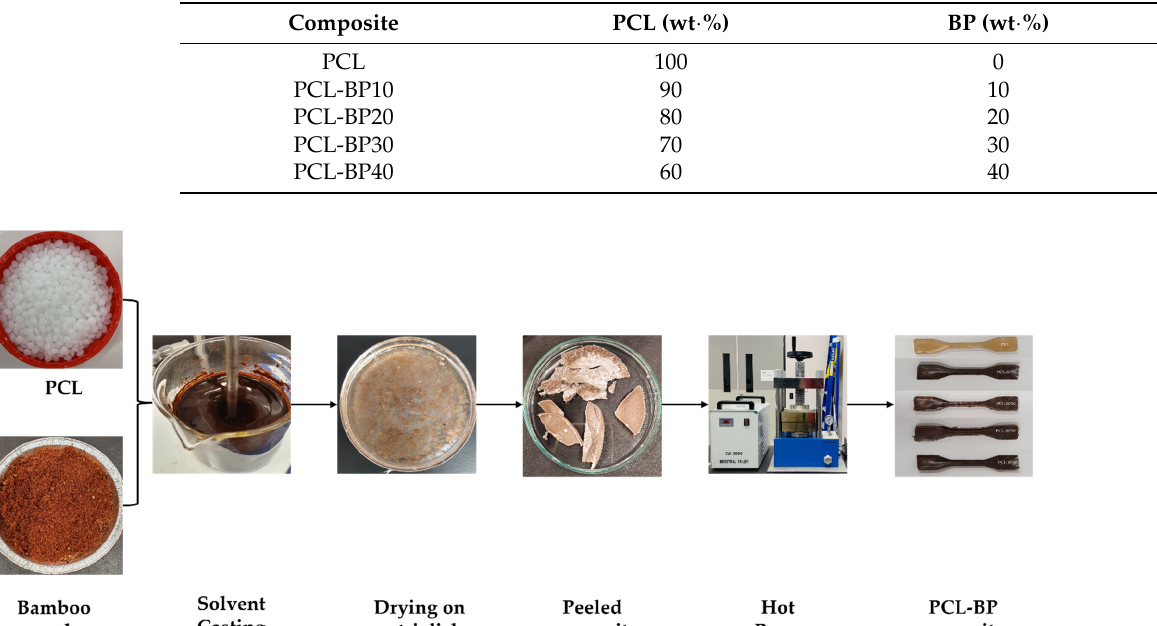
Table 1. Composition of PCL-BP composites.